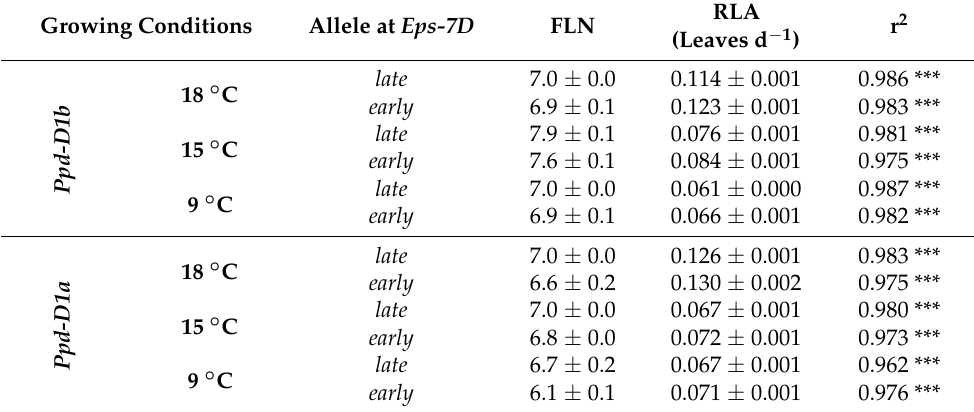
Table 1. Final leaf number (FLN), rate of leaf appearance (RLA; estimated as the slope of the linear regression of leaf number vs. thermal time), and the coefficient of determination for that regression (R 2 ), in NILs of contrasting Eps-7D alleles with backgrounds of contrasting Ppd-D1 alleles at three temperatures under short day. ***: highly significant correlation. RLA Allele at Eps-7D FLN r (Leaves d − 1 )